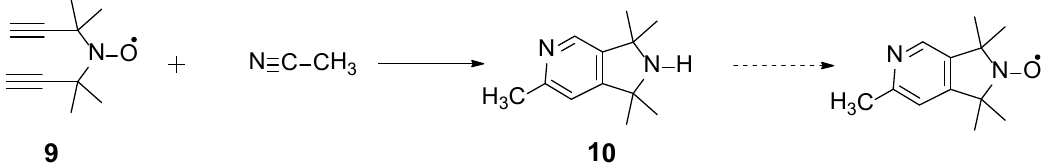
Scheme 3: Preparation of precursor for pyridine annulated pyrroline nitroxide using cobalt (0) catalyzed cycloaddition